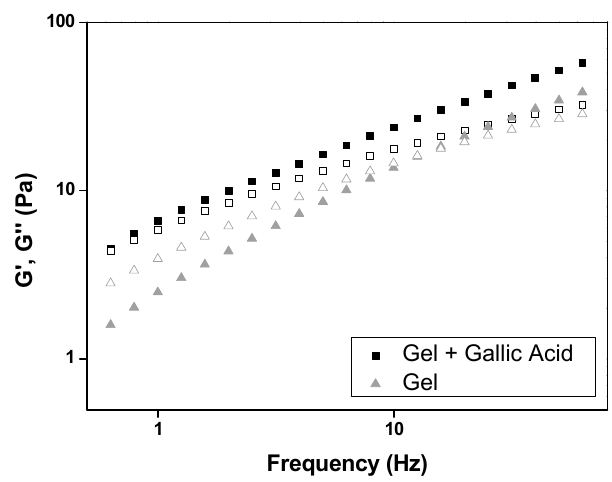
Figure 2. Frequency sweep profile of storage modulus G’ (closed symbols) and loss modulus G” (white symbols) of both gel (gel) and GA-loaded gel (gel + gallic acid). SDs have been omitted for clarity; however, in all cases, the coefficient of variation of triplicate analyses was less than 10%. Data were collected at 32 ± 0.5 °C.